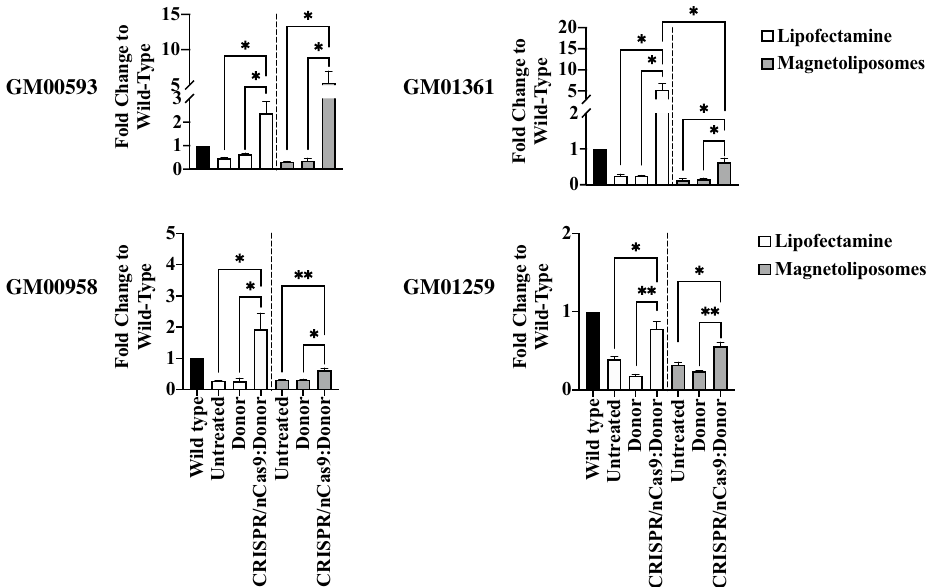
Figure 2. GALNS gene expression on long-term CRISPR/nCas9 treated fibroblasts. The relative transcription fold-change levels to wild-type for MPS IVA fibroblasts after transfection with LP (n = 4) and MLPs (n = 4)-conjugated CRISPR/nCas9 are shown. Fibroblasts were transfected either with the Donor AAVS1:GALNS plasmid (Donor) or the CRISPR/nCas9-Donor AAVS1:GALNS plasmids (CRISPR/ nCas9:Donor). Note that LP allowed a higher transcription for GM01361 fibroblasts treated with CRISPR/nCas9 plus Donor AAVS1:GALNS levels compared to MLPs ( p = 0.0382 ). Fold-change corresponds to comparison between untreated cells in which a reduced mRNA levels were found respect to wild-type (established as 1) as follows: GM00593: 0.47 ± 0.035, GM01361: 0.25 ± 0.052, GM00958: 0.29 ± 0.002, GM01259: 0.3892 ±